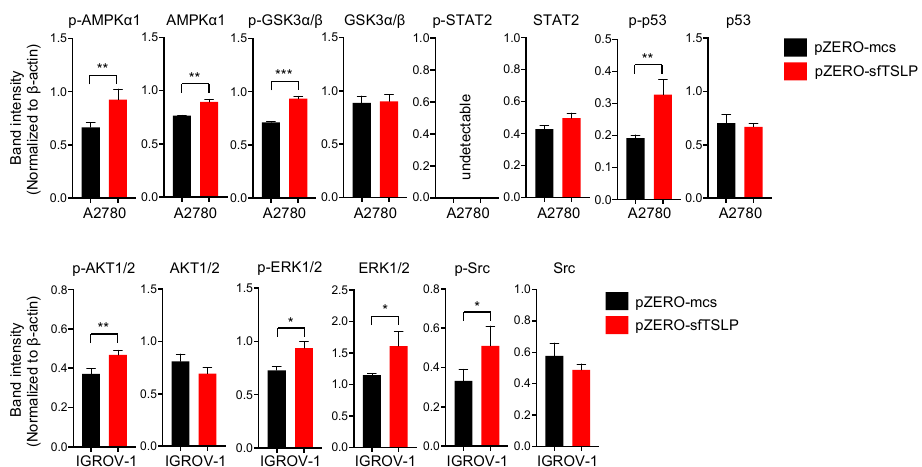
Figure 5. Overexpression of sfTSLP activated intracellular kinases in ovarian cancer cells. ( a ) Human Phospho-Kinase Array was performed in human ovarian (A2780 and IGROV-1) and endometrial (HEC1A) with stable transfection of sfTSLP-expression vector (pZERO-sfTSLP) or empty-vector expression (pZERO-mcs) (upper panel). ( b ) Phosphorylation of GSK3α/β, STAT2 and p53 in A2780 ovarian cancer cells and phosphorylation of AKT1/2, ERK1/2 and Src in IGROV-1 ovarian cancer cells was examined by Western blotting (lower panel). ( c ) To demonstrate clearly the signals of AMPKα1, GSK3α/β, p53, AKT1/2, ERK1/2 and Src that had been activated in response to sfTSLP overexpression in A2780 and IGROV-1 ovarian cancer cell lines, the band intensities of the Western blots were measured and analysed. The band inten- sity of particular phosphorylated or total protein was normalised to that of their corresponding β-actin expression. The whole Western blots showing all bands and molecular weight markers are included in Figure S8. Data shown ( c ) are expressed as mean S.E.M. from three independent replicates (* p < 0.1, ** p < 0.01, *** p < 0.001).